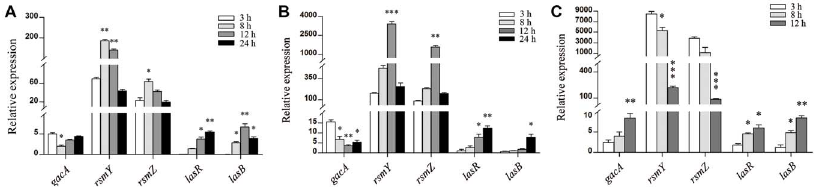
Figure 4. Expression of rsmY and rsmZ was dramatically increased under stressful circumstances. Expression levels of genes were detected in WT PAO1, which was cultivated in (A) LB broth medium (B) MH-S cells as well as (C) LB broth medium containing 2 m g/ml gentamicin at different time-points. Data are means 6 SEM, and representative of three experiments. *, P , 0.05; **, P , 0.01, ***, P , 0.001, one-way ANOVA (Tukey- Kramer post hoc).